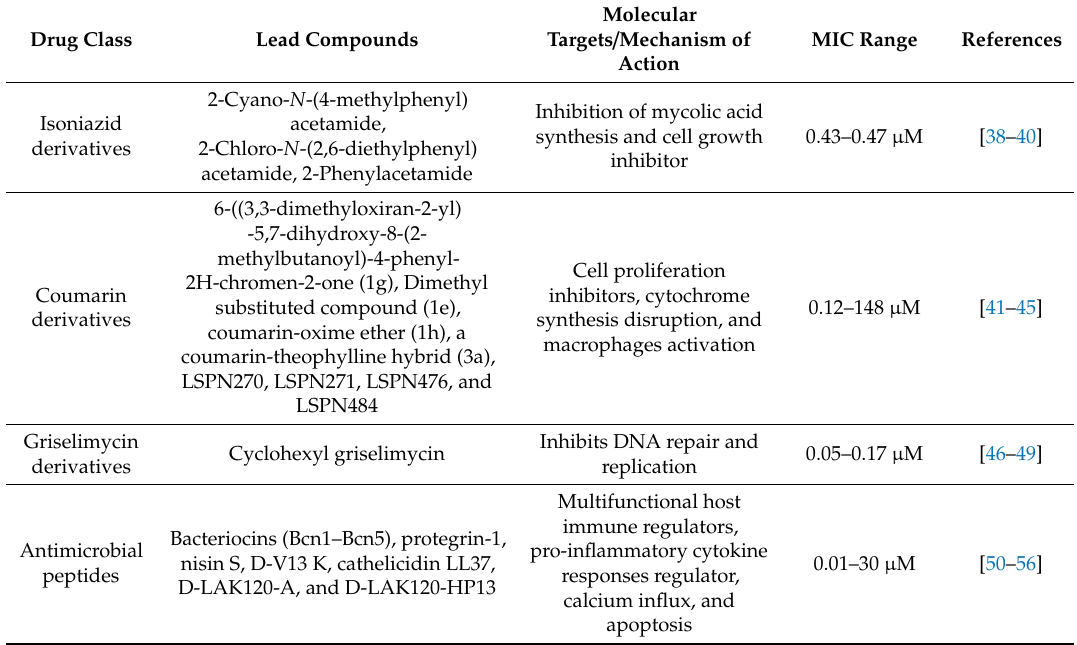
Table 2. Selected chemotherapeutic derivatives and antimicrobial peptides, their molecular targets, mechanism of action, and investigated minimum inhibitory concentration (MIC)